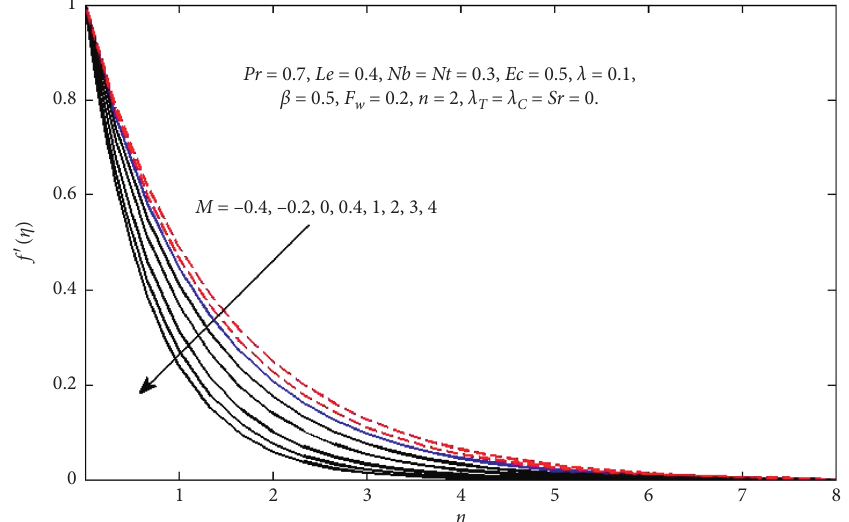
Figure 11: Variation of velocity f ′ concerning η with various values of M .